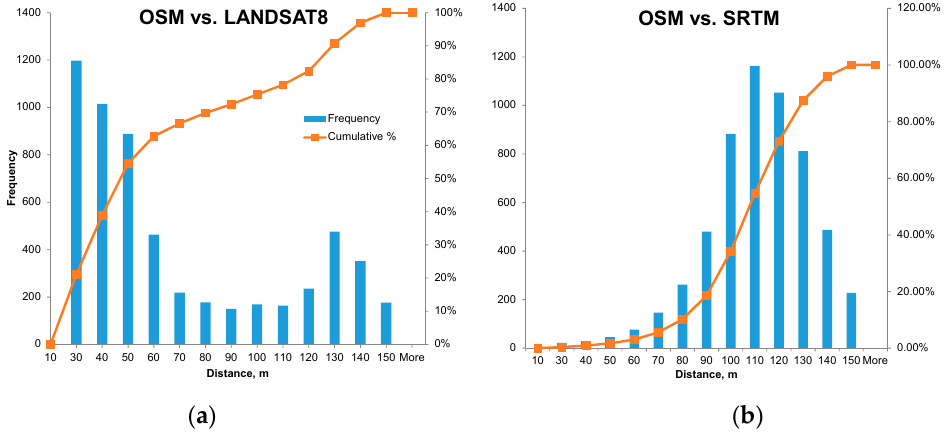
results for two different buffer sizes ( c , d ).